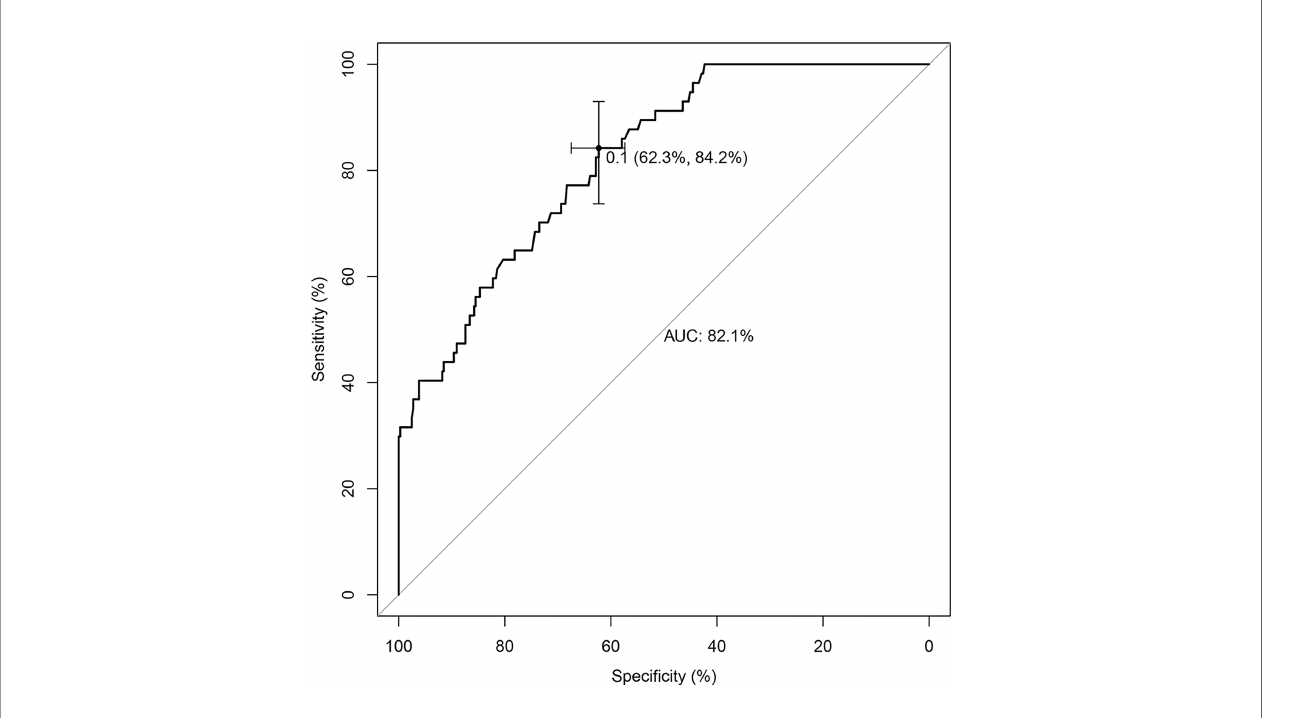
FIGURE 2 | Receiver operator curves of the nomogram.